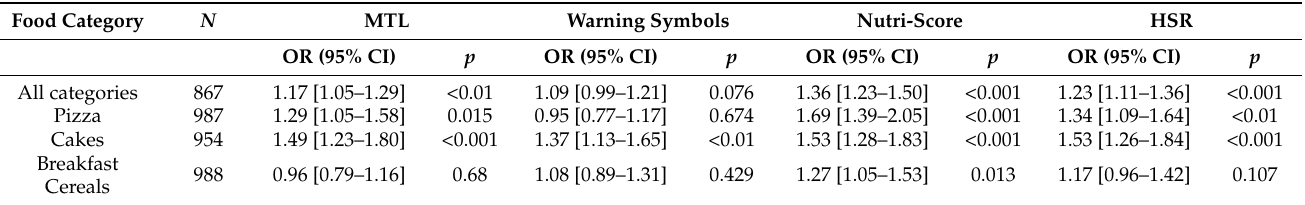
Table 4. Associations between FoPL type and the ability to correctly rank products according to nutritional quality by food category ( N = 1278) using Guideline Daily Amounts (GDA) label as the reference of the models.